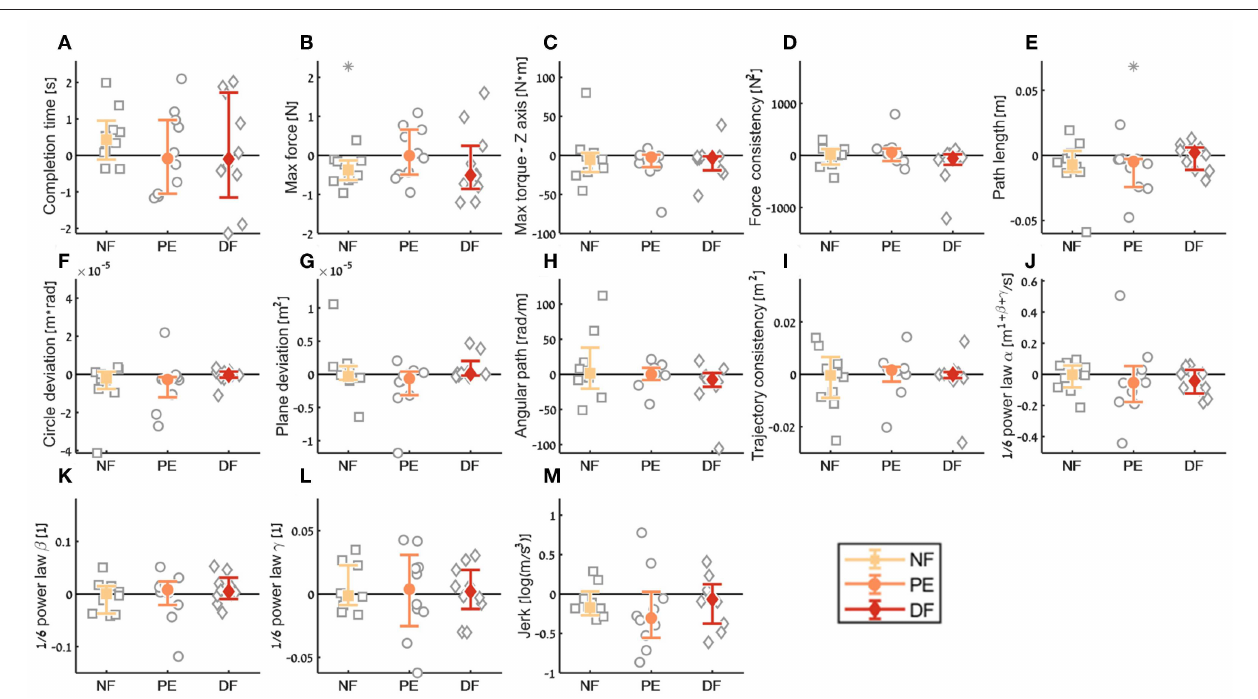
FIGURE 12 | Summary of the open needle driving aftereffect for the insertion subtask. For each metric (A–M) , median of difference between early stage in the second open needle driving to late stage in the first open needle driving are presented. Each gray marker represent individual subject. Error bars shows median of each group difference (NF, PE, and DF) and 95% bootstrap confidence interval. Gray asterisks represent the result of a Wilcoxon sign rank test for difference from